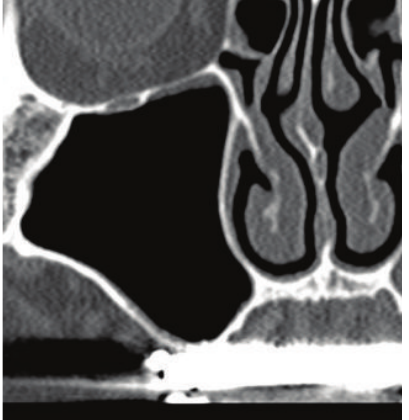
Figure 5: The preoperative CT scan showed insufficient residual height in the right posterior area (Case